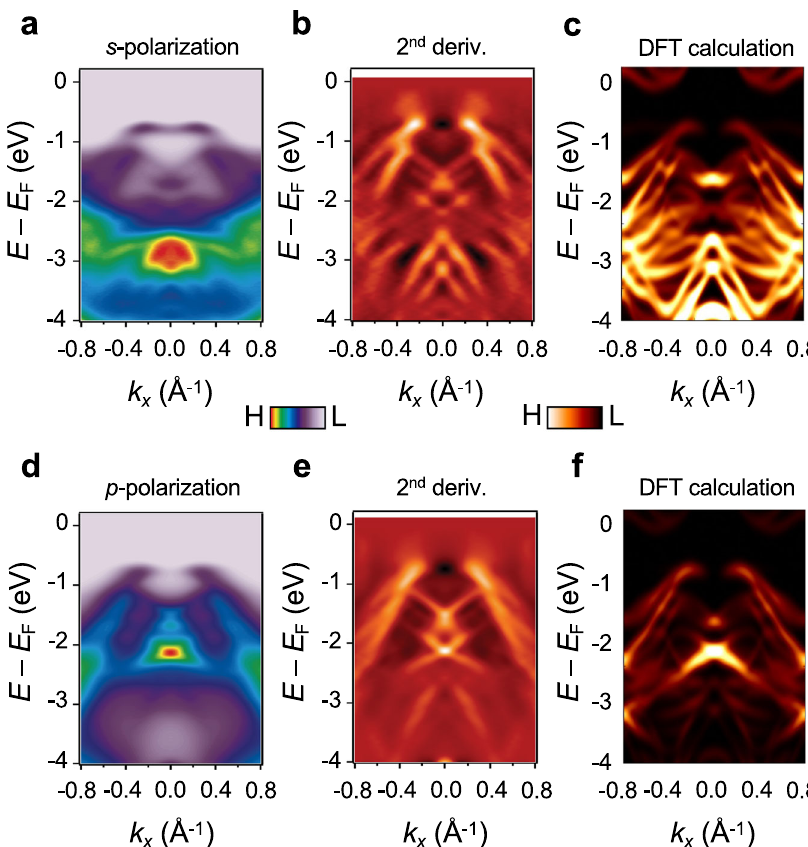
Fig. 3 Polarization dependent ARPES and electronic structure of ML IrTe 2 . a ARPES intensity map of ML IrTe 2 taken along the Μ − Γ − Μ direction using s -polarized photons ( T = 13 K). b Its second derivative with respect to momentum. c In-plane Ir orbitals ( t intensity map of ML IrTe 2 taken along the Μ − Γ − Μ direction using p -polarized photons. e Its second derivative with respect to momentum. f Out-of-plane Ir orbital ( d z 2 )-projected DFT band